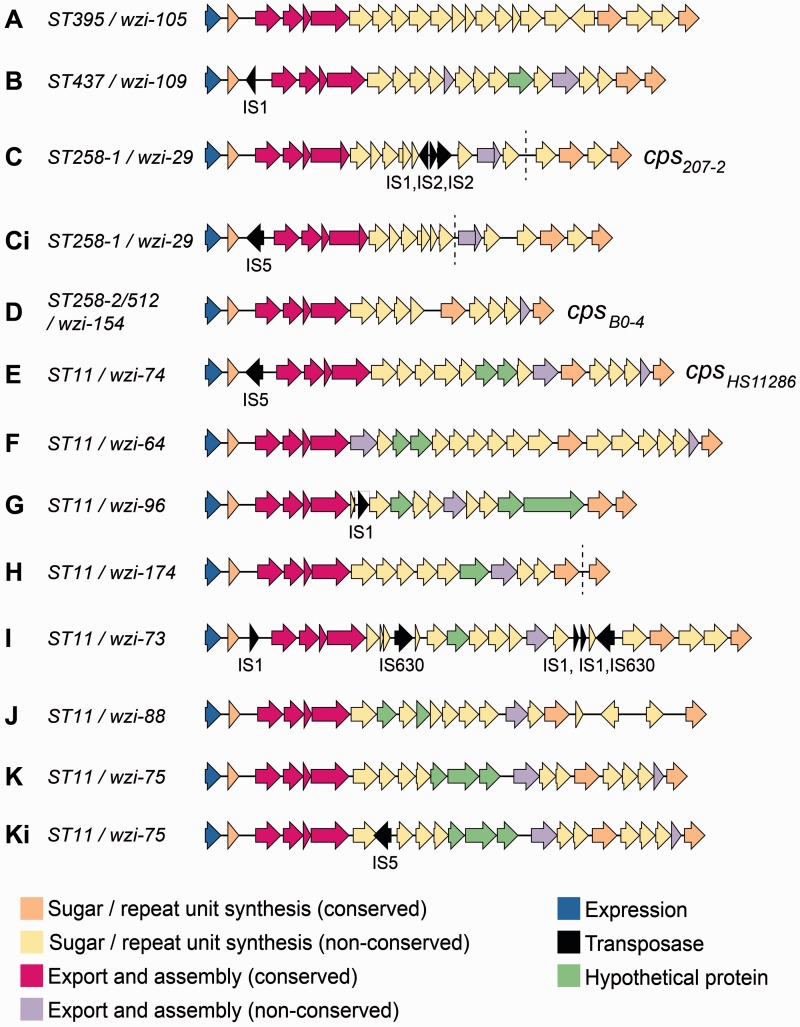
Structures of cps loci identified in Klebsiella pneumoniae CG258. Arrows indicate the direction, relative length, and function (colored as per legend) of protein-coding genes. Transposases were identified and labeled using the IS finder database (https://www-is.biotoul.fr/, last accessed April 23, 2015). Cps loci are labeled A through K as referred to in the text (table 1 and fig. 2); STs and wzi alleles are indicated; loci previously named in D’Andrea et al. (2014) are indicated (cpsB0-4, cps207-2, and cpsHS11286). Cps loci that vary from another only in the content and/or position of transposases are indicated by “i.” Dashed lines indicate contig breaks in assemblies of three loci.